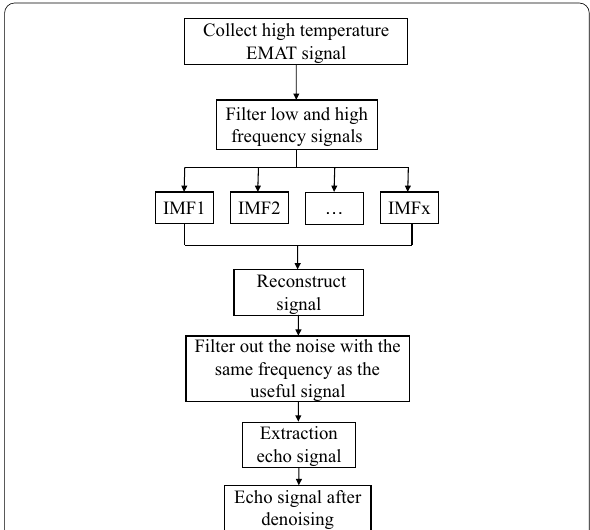
Figure 4 Algorithm flow chart